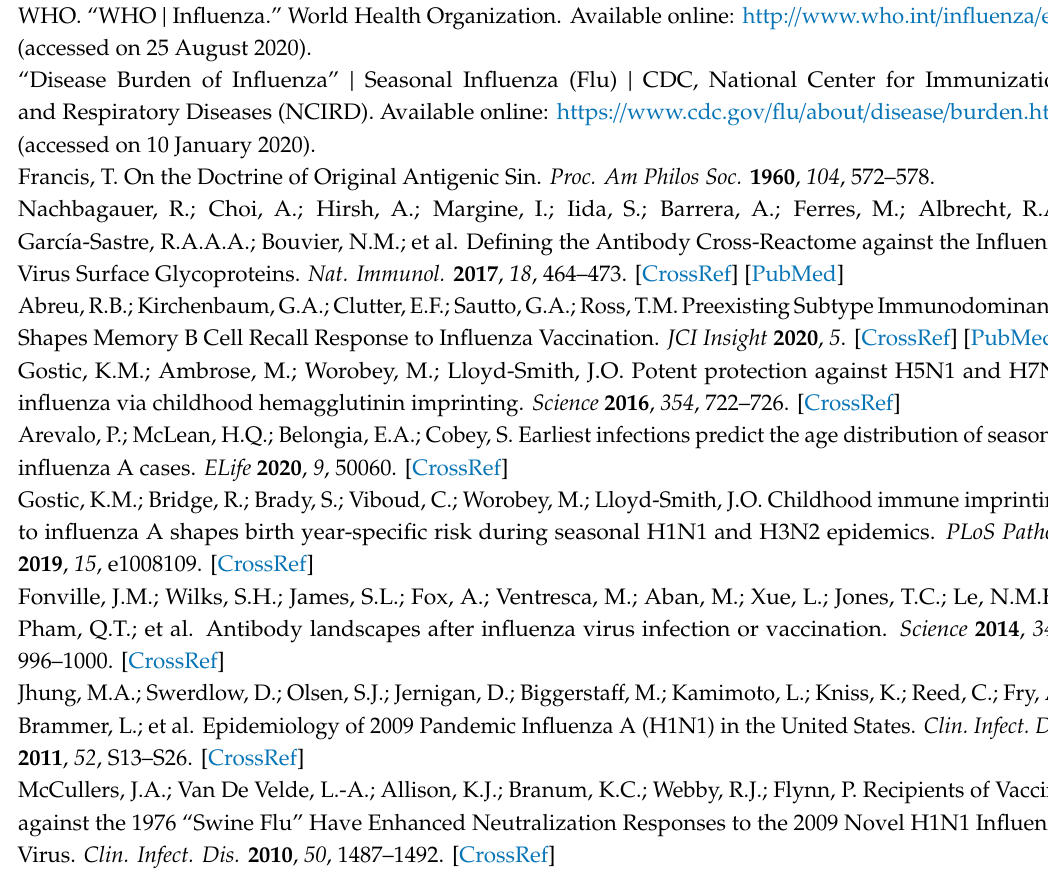
Figure S1: Subgroup analysis of HAI fold change (between baseline and 28 days post-vaccination) for each cohort (H3N2 birth cohort, panel A and B; H1N1 birth cohort, panel C and D) by vaccination history. No significant imprinting e ff ects were observed, even when stratified by vaccination history, Figure S2: Baseline HAI titers against the historical H1N1 A / Denver / 1957 strain. Left: H3N2 birth cohort. Right: H1N1 birth cohort. 9 / 10 individuals in the H1N1 birth cohort had titers equal to or greater than 40 at baseline, which demonstrates pre-existing immunity to this